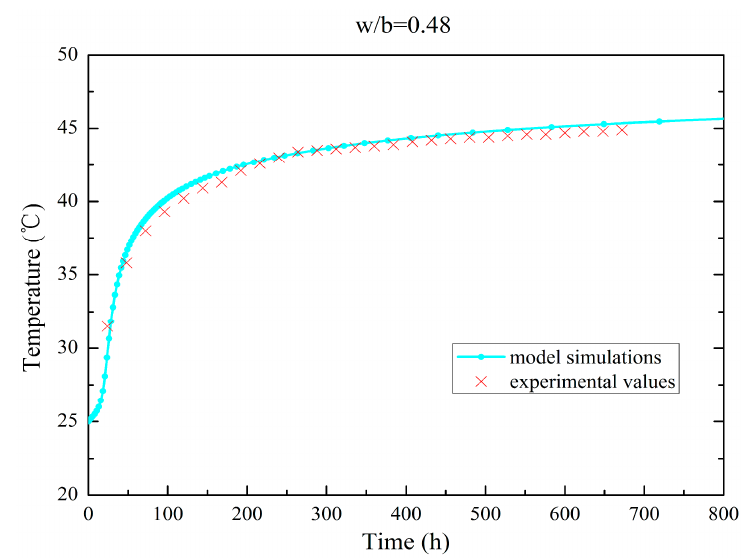
Figure 2. Temperature evolution for adiabatic test of fly ash concrete (w/b = 0.48).